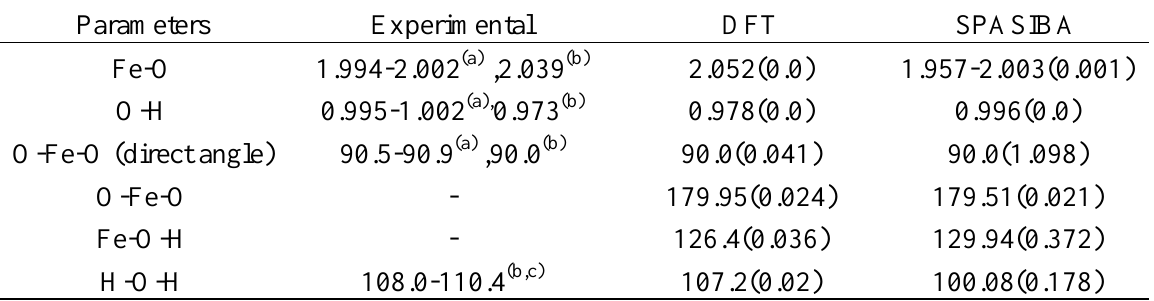
Table 2a. DFT (sextet electronic state) and SPASIBA optimized structural parameters for the ferric